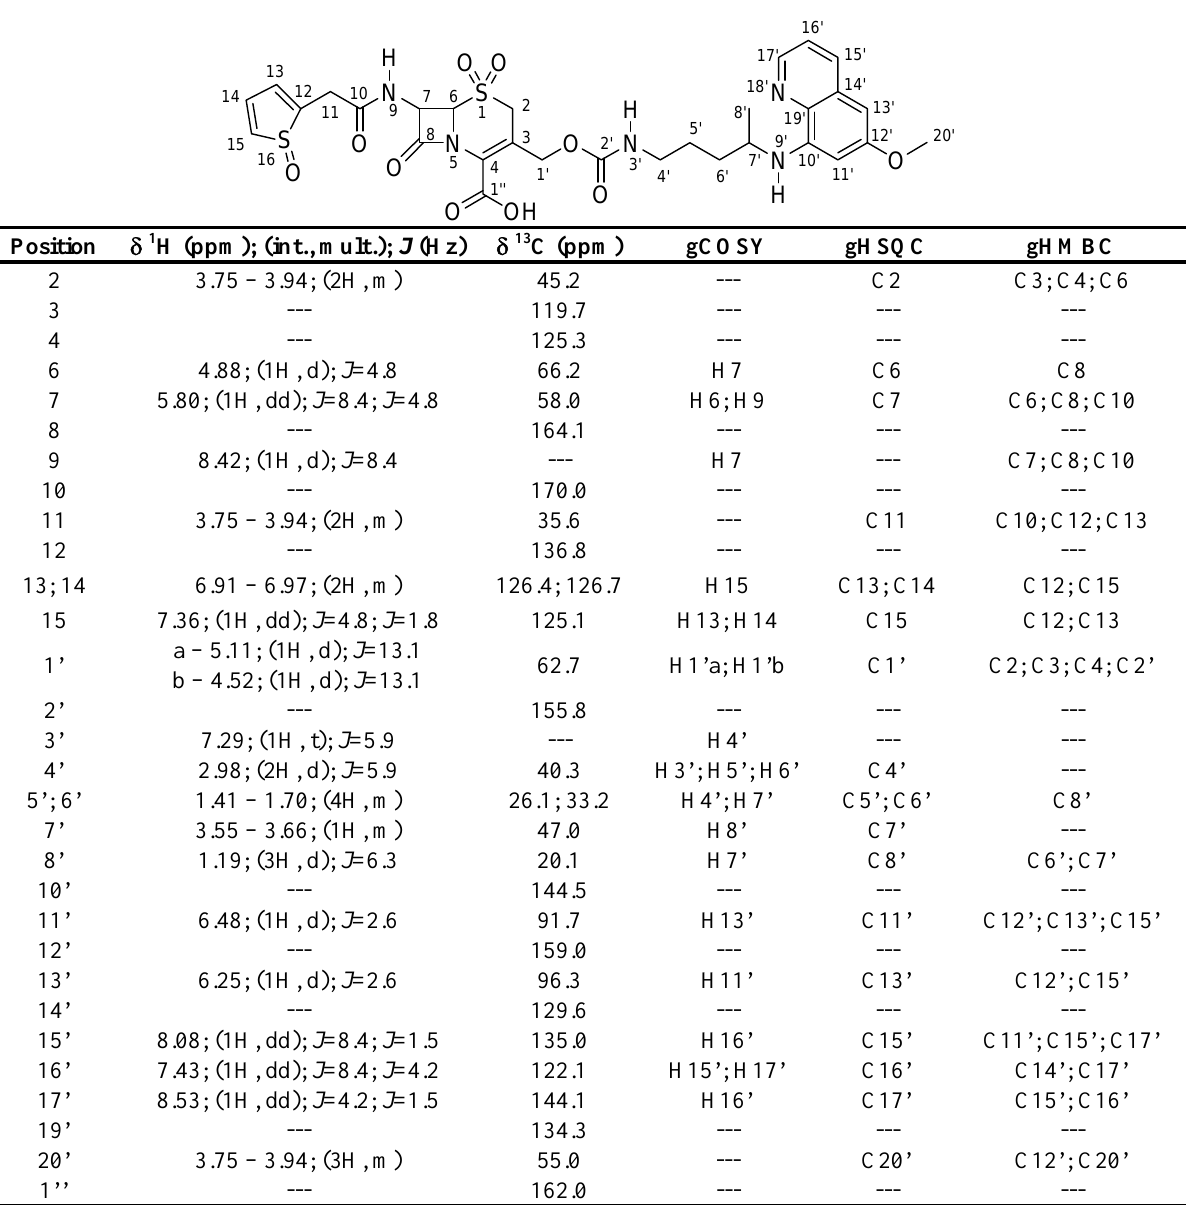
Table 3. 1 H- and 13 C-NMR chemical shifts for compound 7